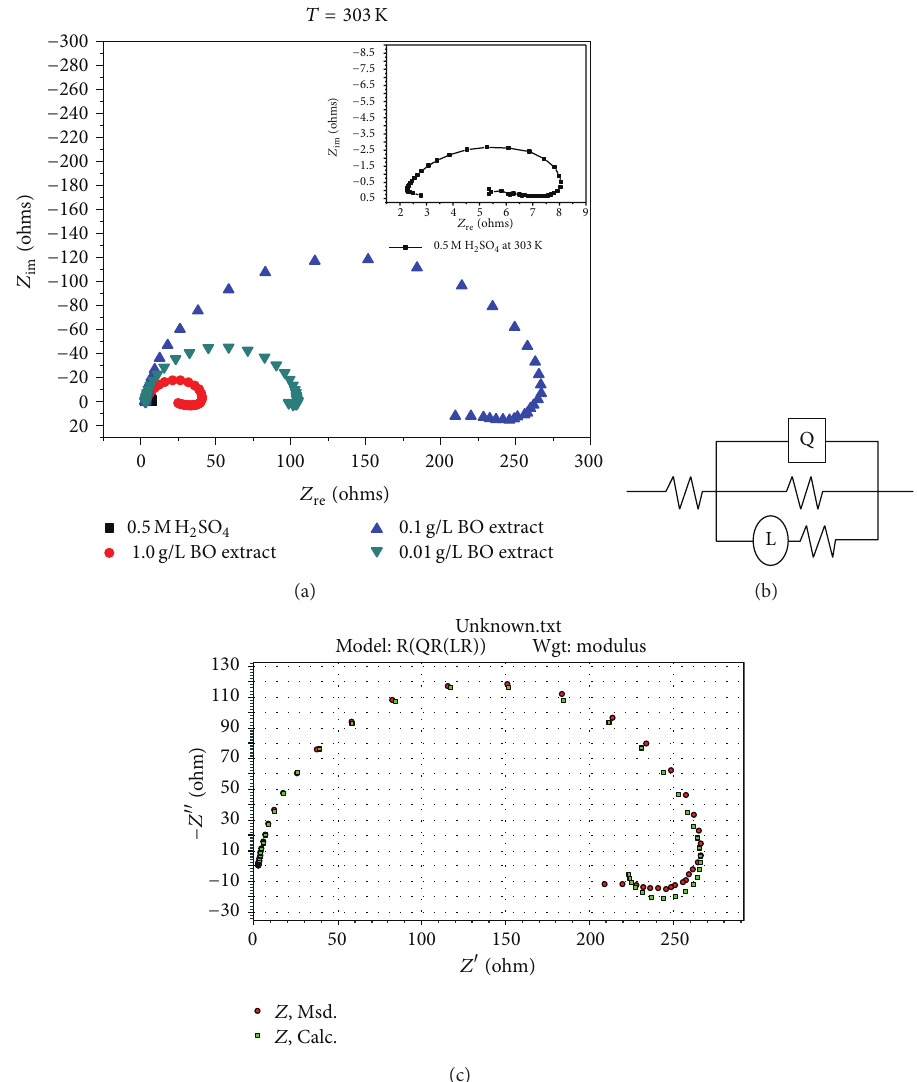
Figure 5: (a) Nyquist plot for pipeline steel in 0.5 M H 2 SO 4 with and without different concentrations of Brassica oleracea extract at 303 K. (b) Electrochemical equivalent circuit for impedance response of pipeline steel in 0.5 M H 2 SO 4 with and without different concentrations of Brassica oleracea extract at 303 K. (c) ZSimpWin plot of experimental and computer impedance data for pipeline steel in 0.5 M H 2 SO 4 with 0.1g/L